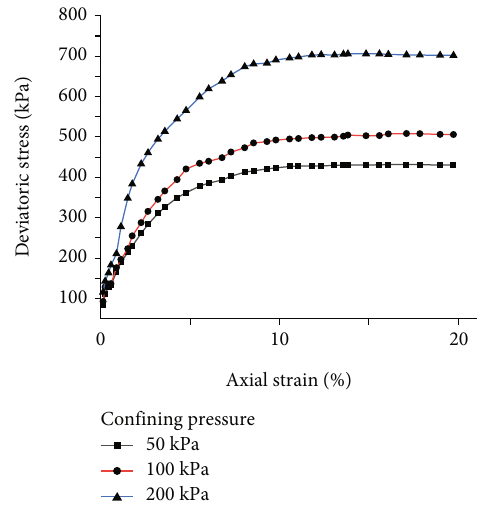
Figure 4: Deviatoric stress-axial strains of plain soil samples under di ff erent con fi ning